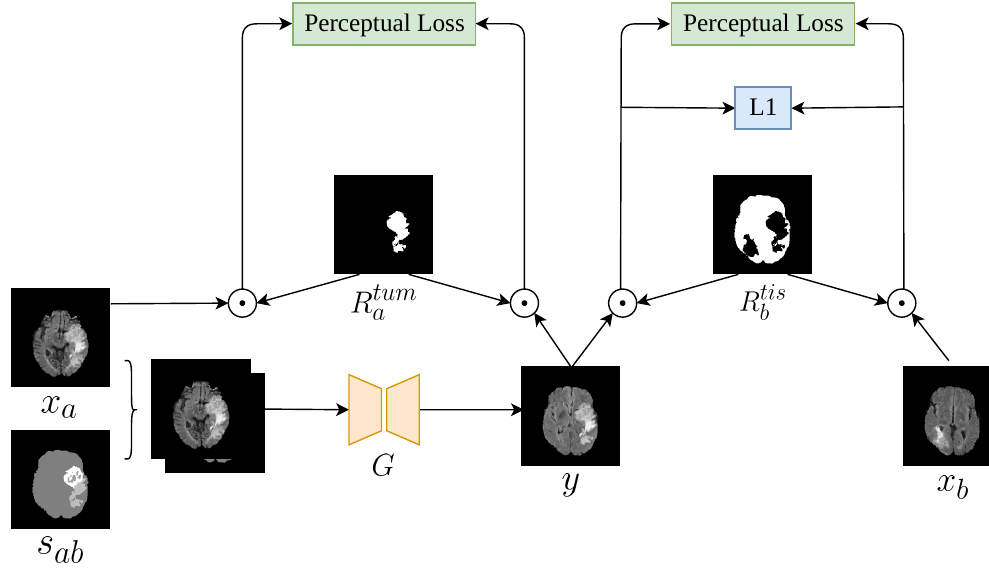
Figure 5. Computation details of the perceptual loss and L 1 loss. R tum a is a mask for the x tumor; R tis a mask of the x b tissue, except for the x b and x a tumor